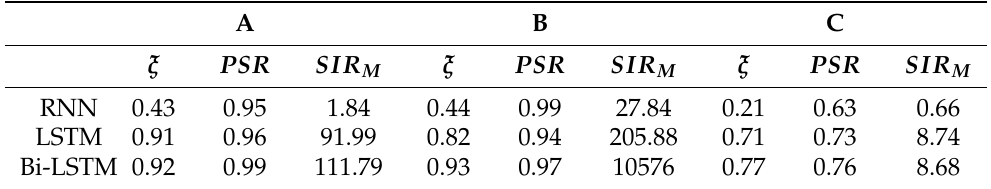
Table 7. Comparison of RNN, LSTM and Bi-LSTM